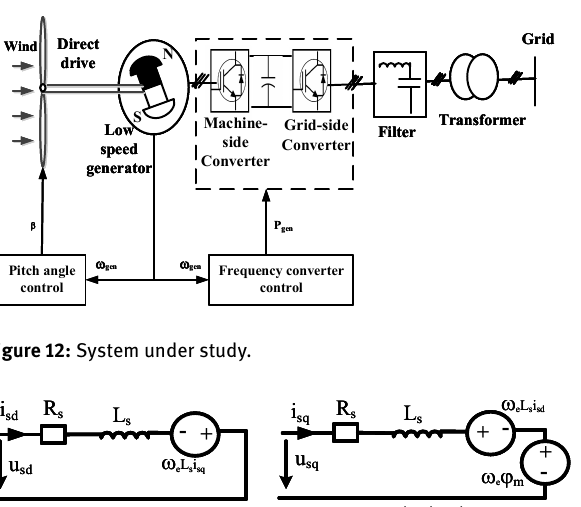
Figure 11: Lifetime estimation model for power semiconductor devices.